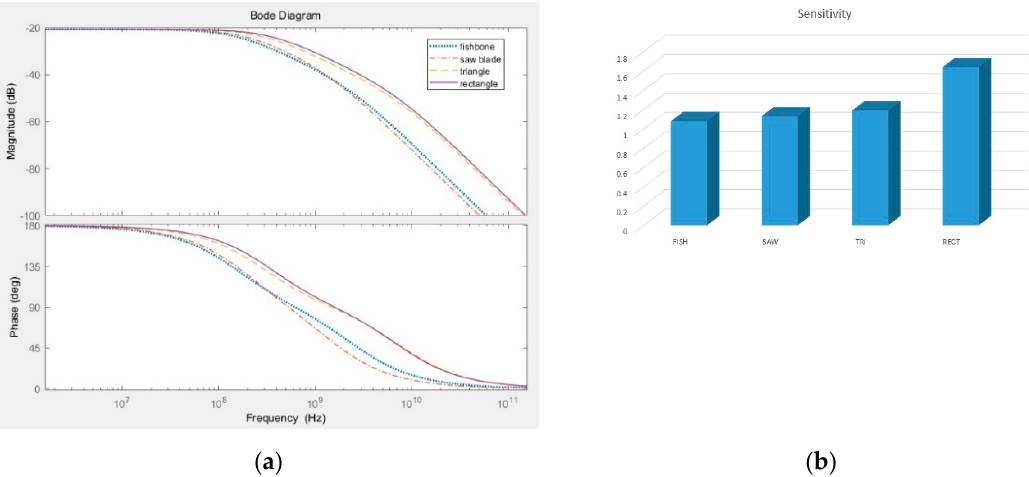
Figure 4. Comparison between pick-up coils without integrator: ( a ) frequency response of sensor coil at M = 1.15 nH; ( b ) coil sensitivity at L s = 19 nH.